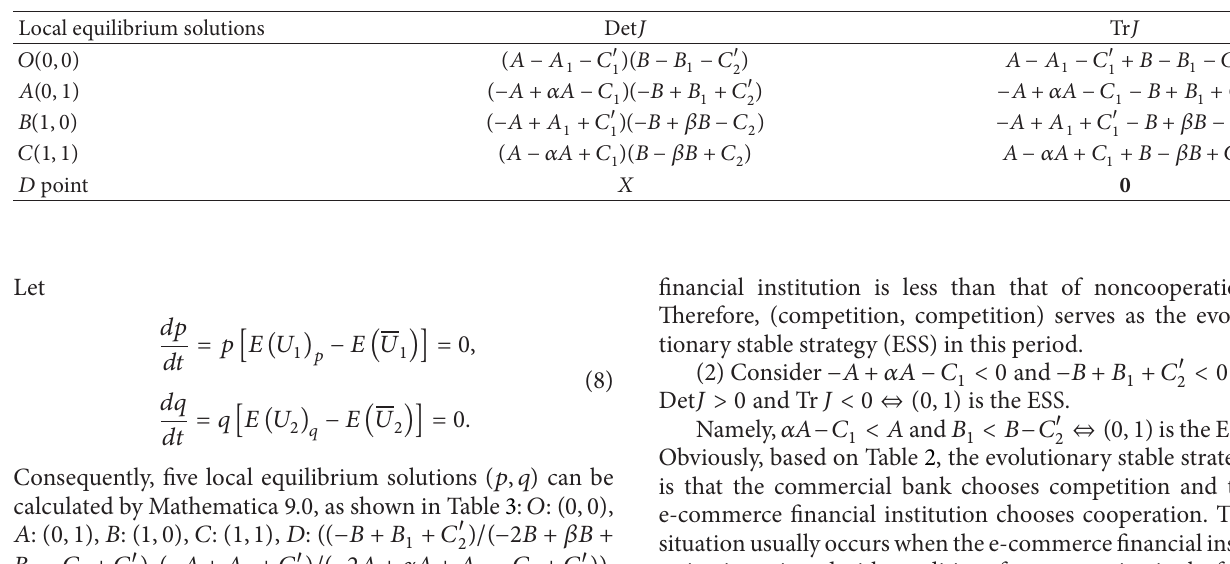
Table 3: Stability test calculations of local equilibrium